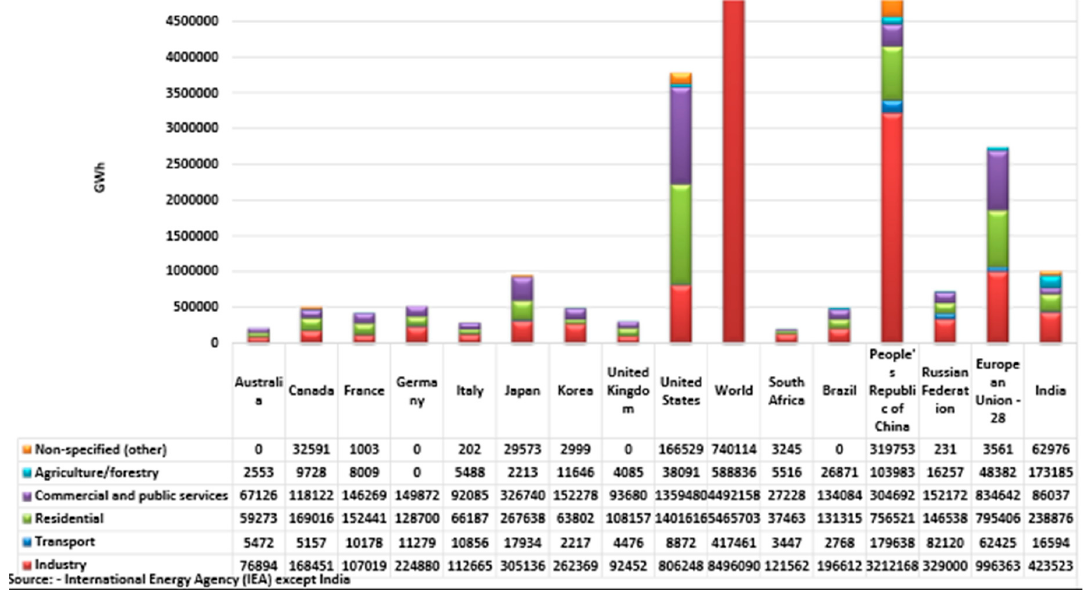
Figure 4. Category-wise Electricity Consumption across various countries (2015).